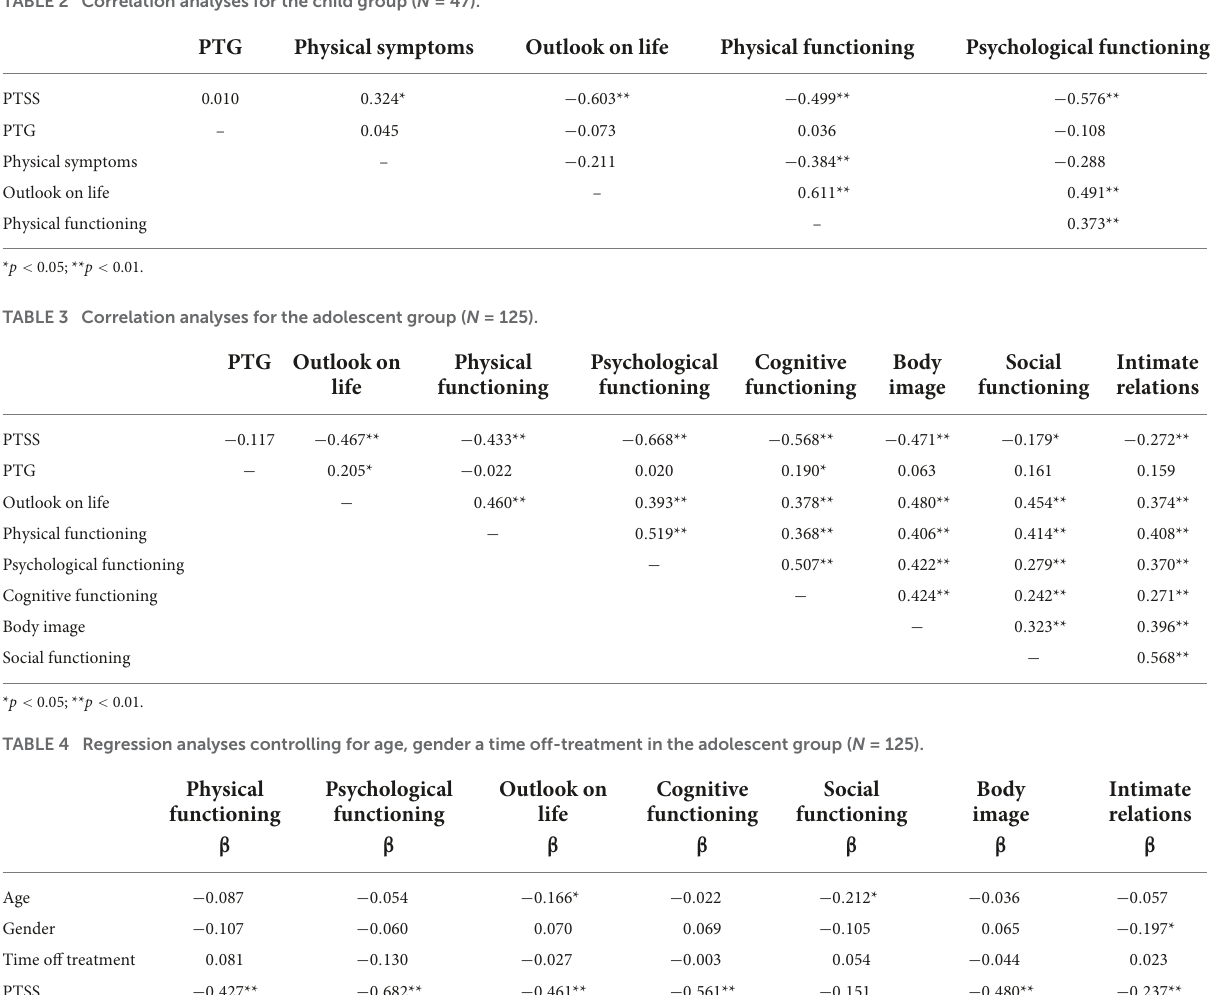
TABLE 2 Correlation analyses for the child group ( N = 47).